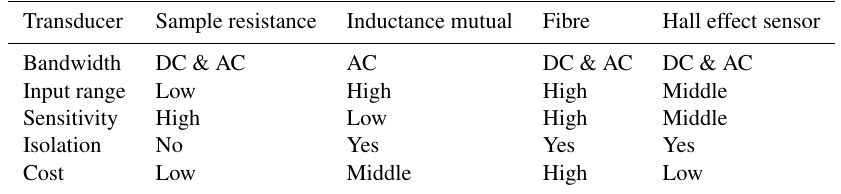
Table 2. Performance comparison of different current transducers.